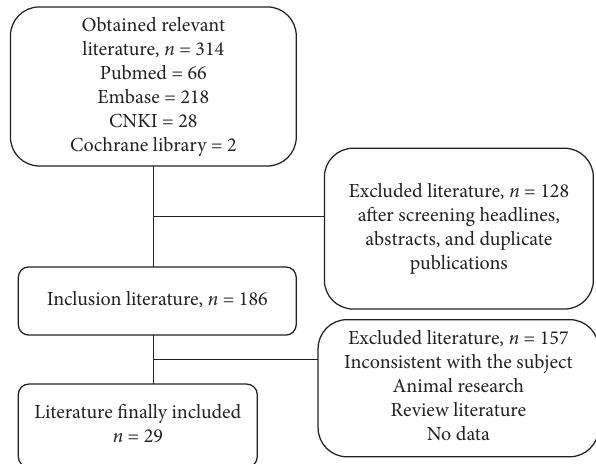
Figure 1: The process of study